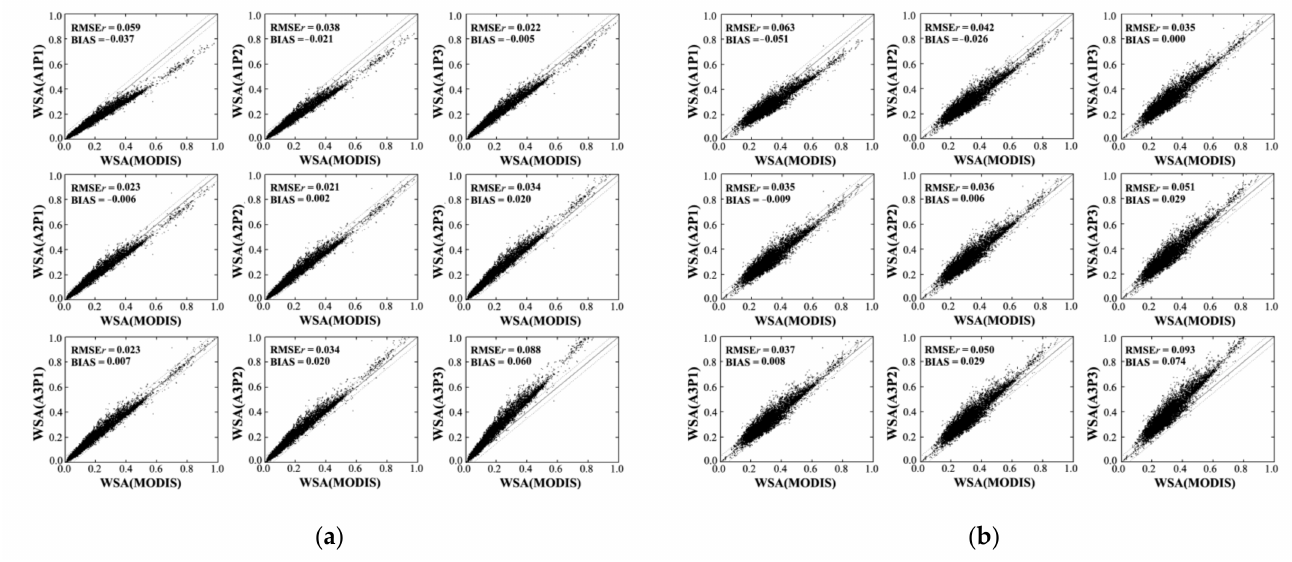
Figure 8. Comparison of MODIS albedo with albedo retrieval from different BRDF archetypes and nadir reflectance in the red ( a ) and NIR ( b )